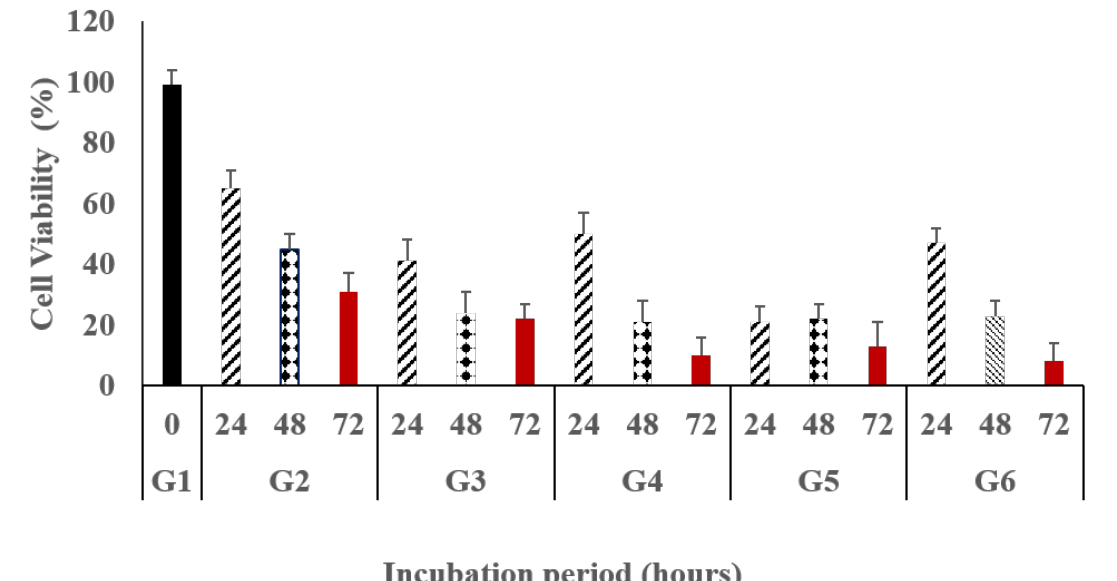
Table 5. The percentage of breast cancer cell viability measurements as a function of the incubation period for all modified hydrogel systems compared to either free drug solutions or untreated groups, taking 200 μg/mL as a fixed concentration for all groups.